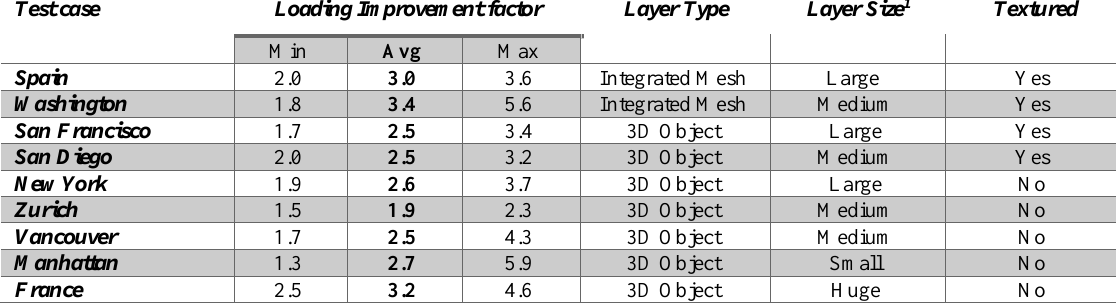
Table 2 . Loading Improvement factors of OGC I3S 1.2 over I3S OGC 1.1 Community Standard. These improvements were measured using the ArcGIS JS API client application.